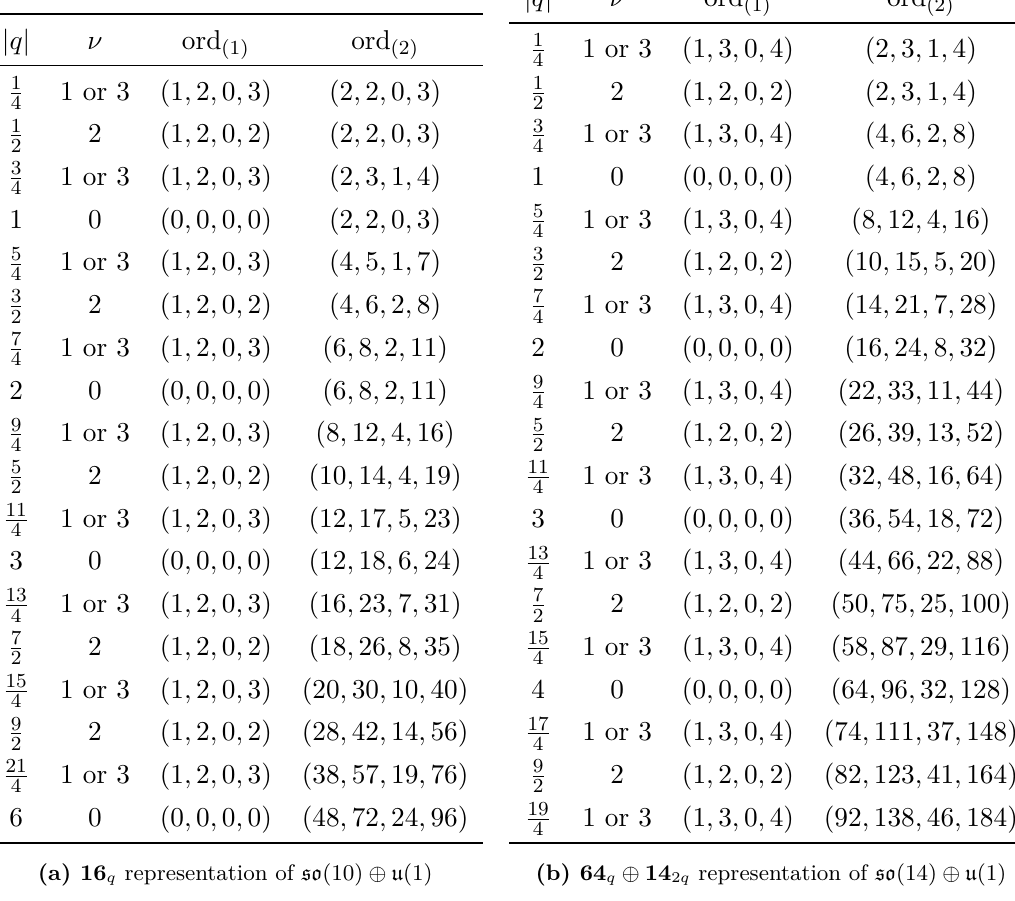
Table 14. Orders of vanishing for various combinations of ν and pseudo-charge q and for spinor matter in so (4 k + 2) ⊕ u (1) models. The so (10) ⊕ u (1) data are found using the model in eq. (8.1), while the so (14) ⊕ u (1) data are found using the model in eq.